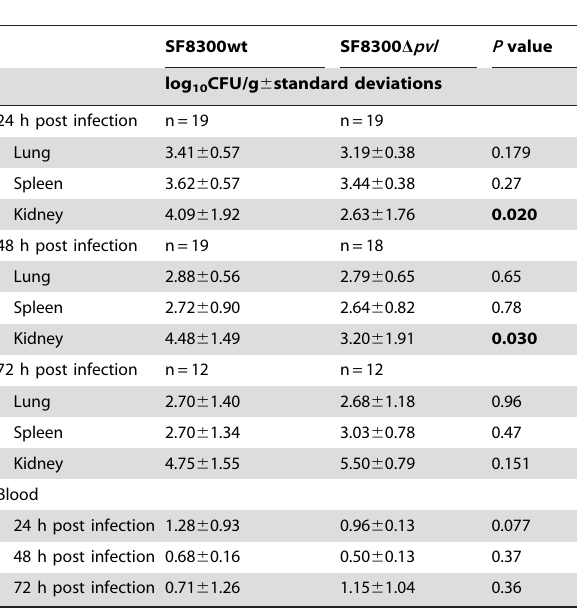
Table 4. Time-course single-strain infection experiments with a USA300 parental or isogenic D pvl mutant strains. 1